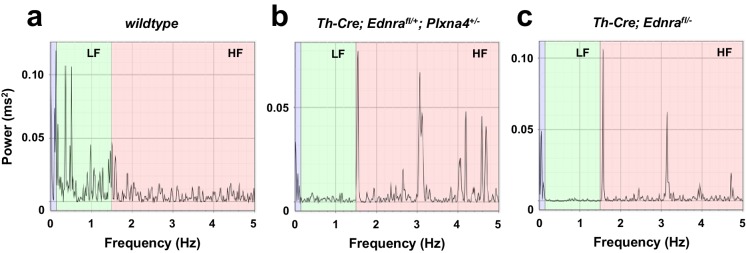
Reduced baseline sympathetic activity in Ednra-Plxna4 trans-heterozygous heart.(a–c) Power spectrum plots of baseline heart rate fluctuation in Th-Cre; Ednrafl/+; Plxna4+/- (b), Th-Cre; Ednrafl/- (c) mutants, and a littermate control (a). The cardiac interbeat intervals in very-low-frequency (0–0.15 Hz; purple), low-frequency (0.15–1.5 Hz; green), and high-frequency (1.5–5 Hz; pink) domains demonstrate that sympathetic nerve activity drives the interval spectrum towards the low frequency component in wildtype (a), whereas reduced sympathetic nerve inputs shift the spectrum to the high-frequency domain in Th-Cre; Ednrafl/+; Plxna4+/- (b) and Th-Cre; Ednrafl/- (c) mutants.